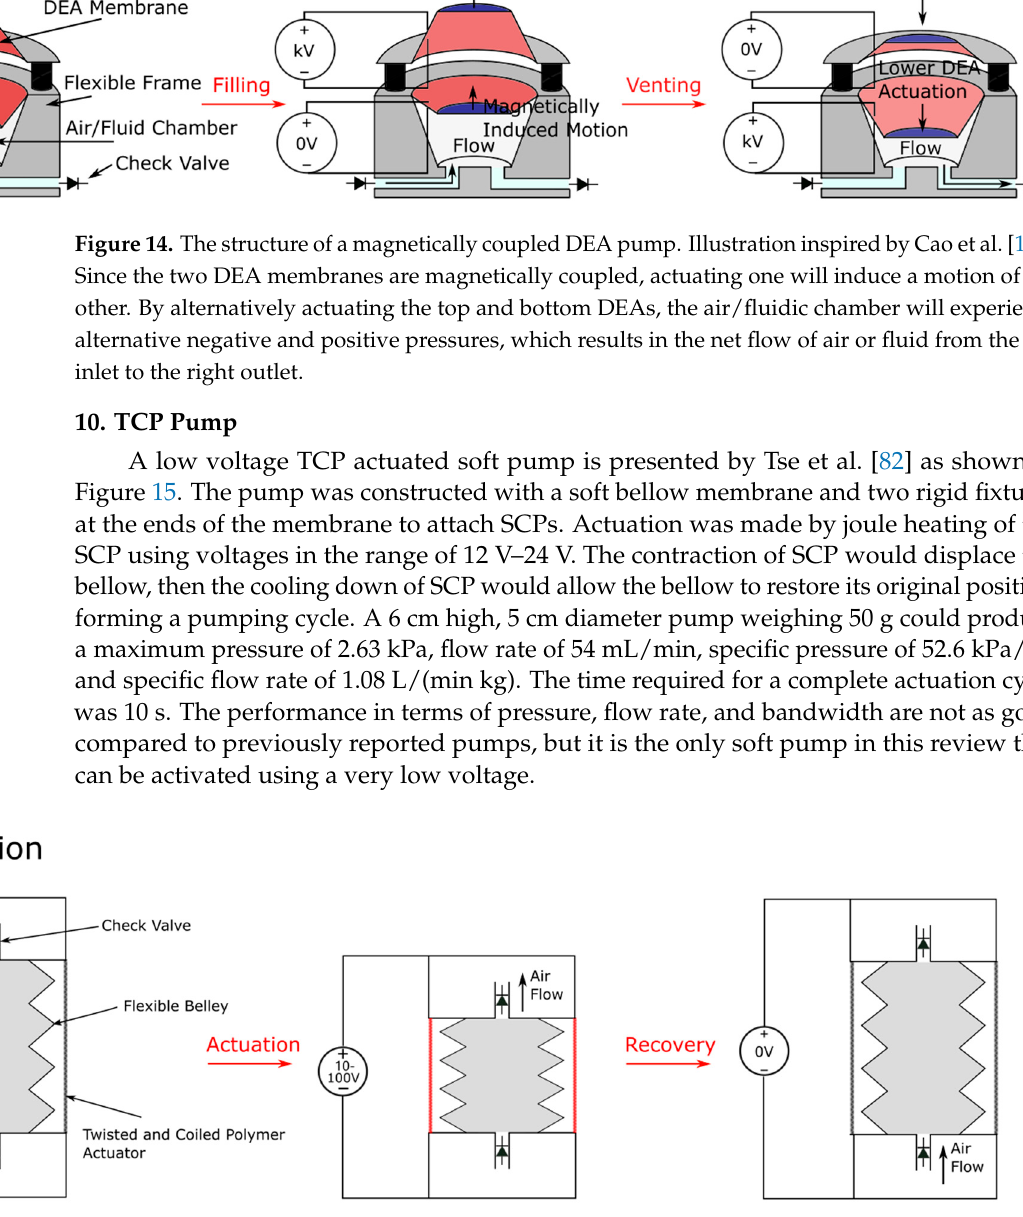
Figure 15. The structure of a TCP pump. Illustration inspired by Tse et al. [82]. Joule heating the TCPs using an electrical power source will cause the TCPs to contract, which compresses the flexible bellow and pushes air out through the top check valve. During the cooling down process, the bellow will recover to its uncompressed state due to elasticity and air will refill the bellow through the bottom check valve.